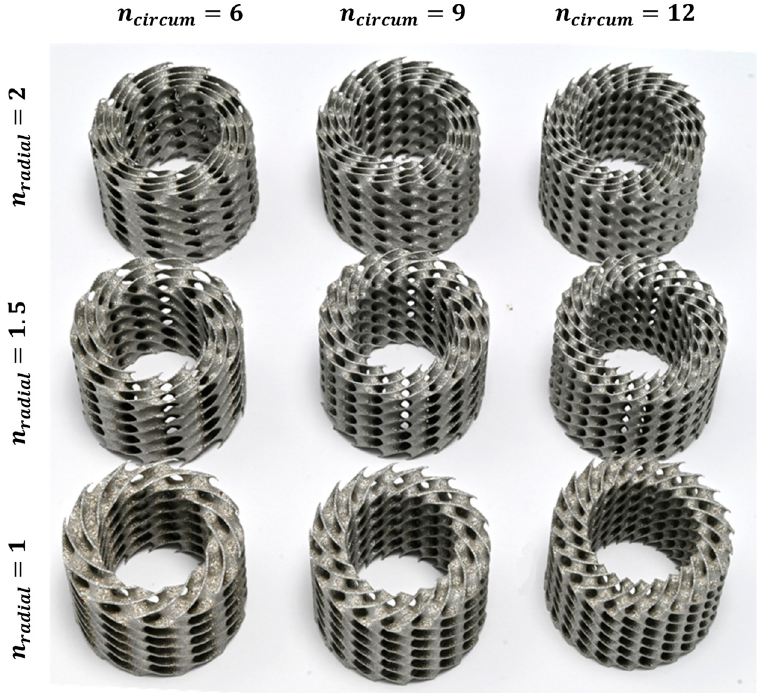
Figure 4. Diamond TPMS cylindrical structures fabricated by selective laser melting (SLM) of 316L stainless steel powder used in the study.